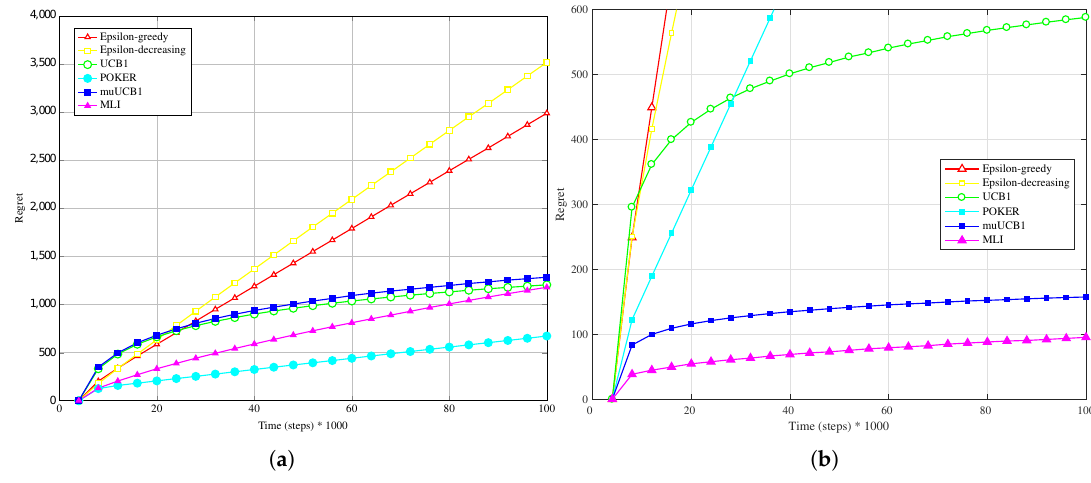
Figure 2. Performance in terms of regret of the six considered algorithms, with a Bernoulli distribution for the reward PDF and T U / T M = 5. ( a ) Hard configuration; ( b ) Easy